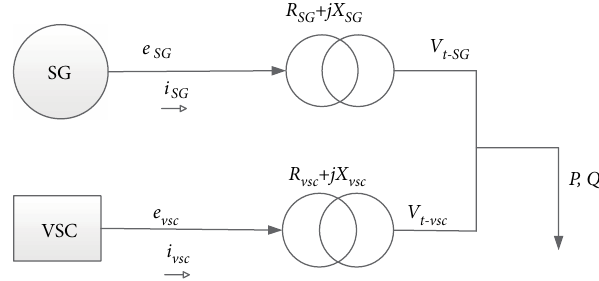
Figure 13: Block diagram of voltage‐control units connected in parallel for briefing voltage droop